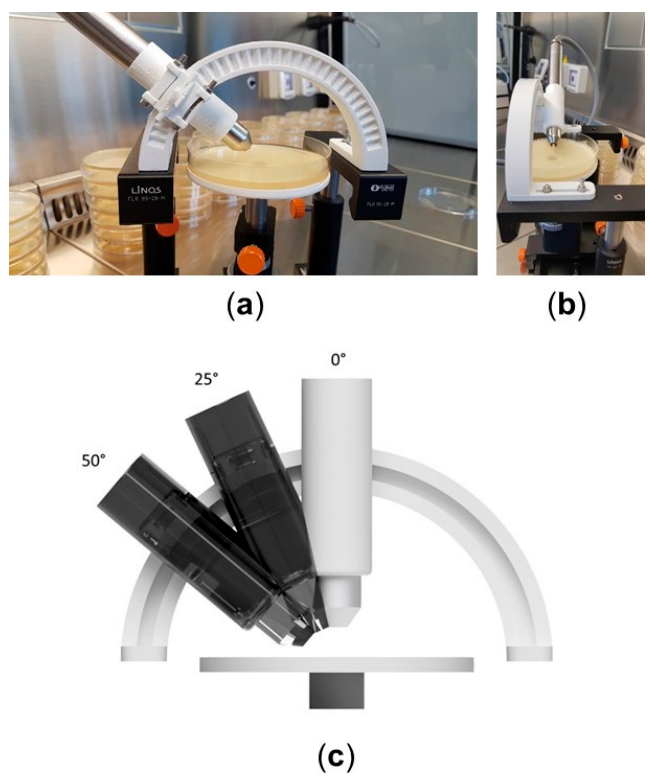
Figure 2. Experimental setup for the determination of the plasma effective area; ( a ) photo: direction for the tilted treatment (incidence angle: from top to left), ( b ) sideview, ( c ) scheme.